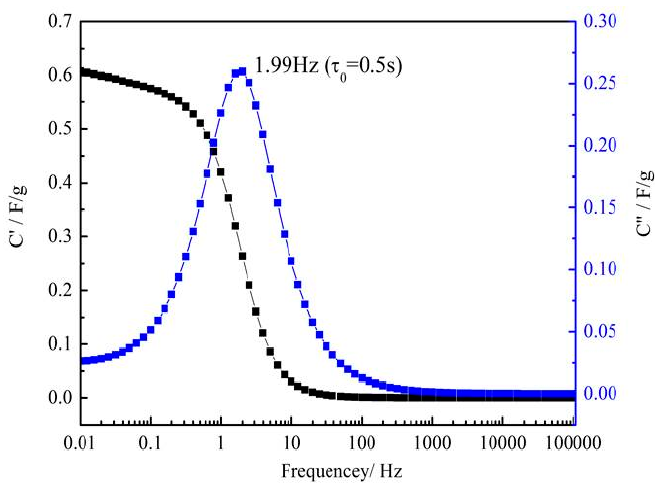
Figure 8. Real (C ′ ) and imaginary (C ″ ) parts of specific capacitance of ECNFs-6. Figure 8. Real (C (cid:48) ) and imaginary (C (cid:48)(cid:48) ) parts of specific capacitance of